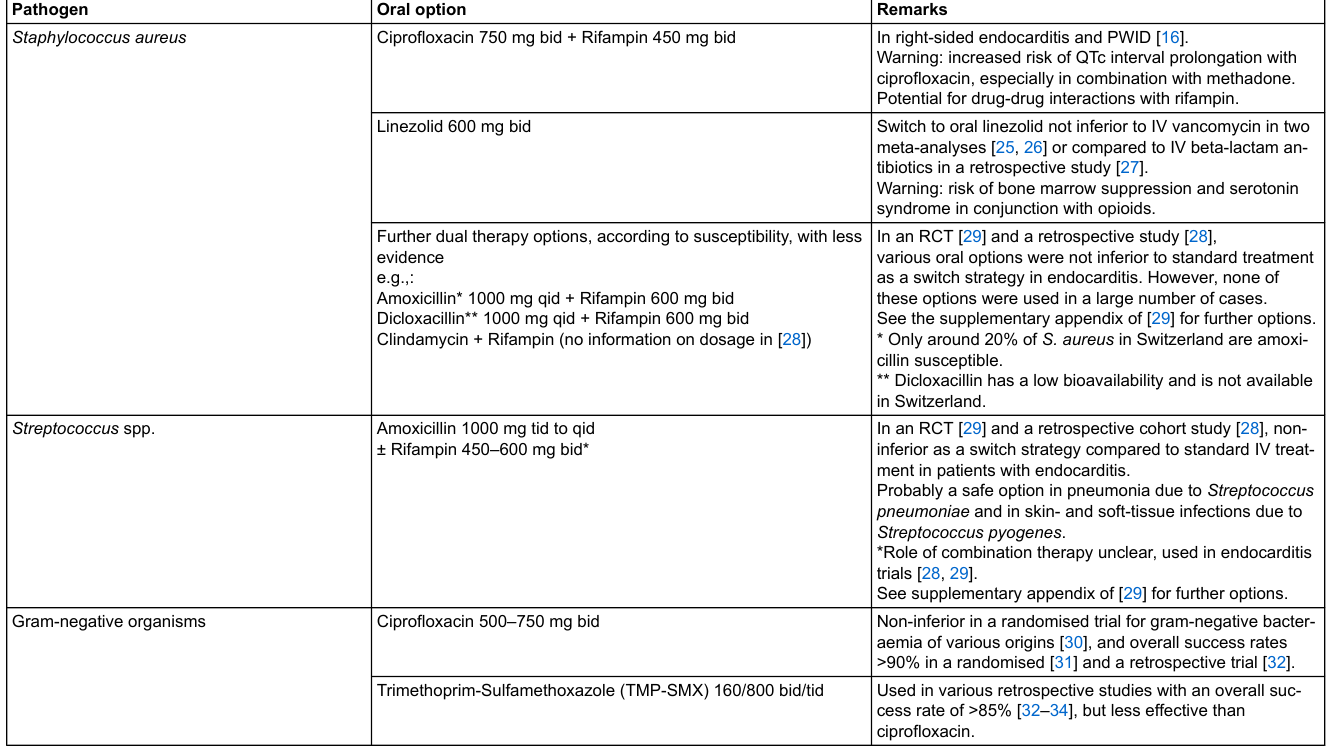
Table 3: Oral antimicrobial therapy options for bacteremic infections caused by important pathogens in PWID.